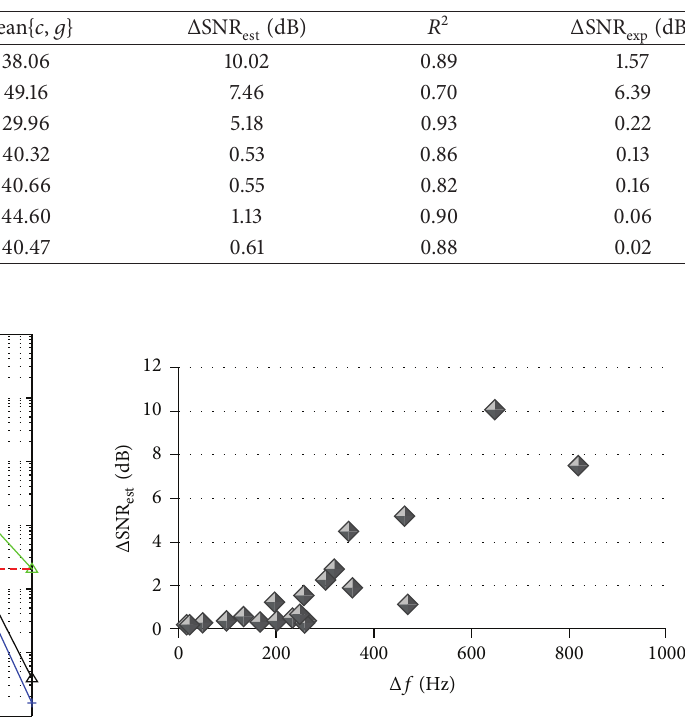
Figure 7: Difference in SNR values for BER equal to 2 ⋅ ) as a function of the spectral width Δ𝑓 10 −4 (Δ SNR est